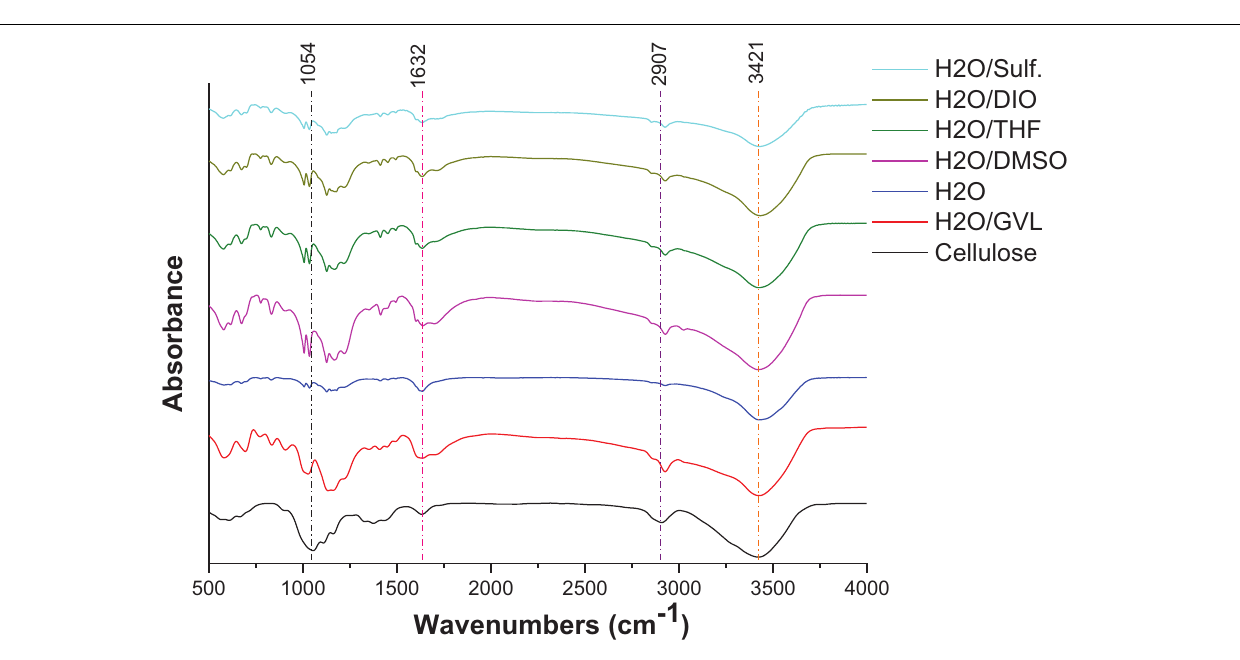
FIGURE 2 | Overall reaction pathway for acid-catalyzed production of LA from cellulose in biphasic solvent systems. The main intermediate compounds and target products are detected by HPLC.